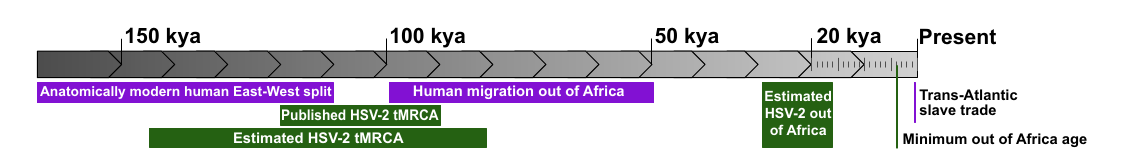
Fig.5|TimelineofinferredHSV-2diversi fi cationeventswithcontextofhuman activity. Purple segmentsdenote events associated with human activity. Green segments denote viral evolutionary events. Timing of the deepest